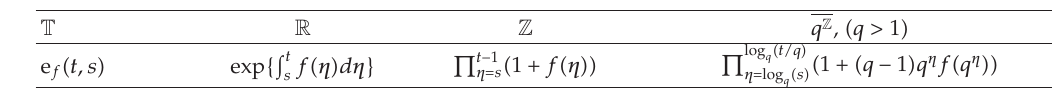
Table 2: The exponential